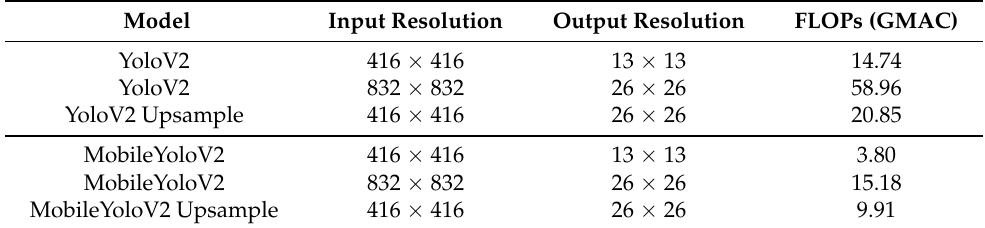
Figure 5. YoloV2 reorg technique vs our upsample technique for concatenation. The reorg technique splits the bigger feature map, whilst the upsample technique increases the resolution of the smaller feature map. Table 3. Complexity of YoloV2 and our proposed variants on Pascal